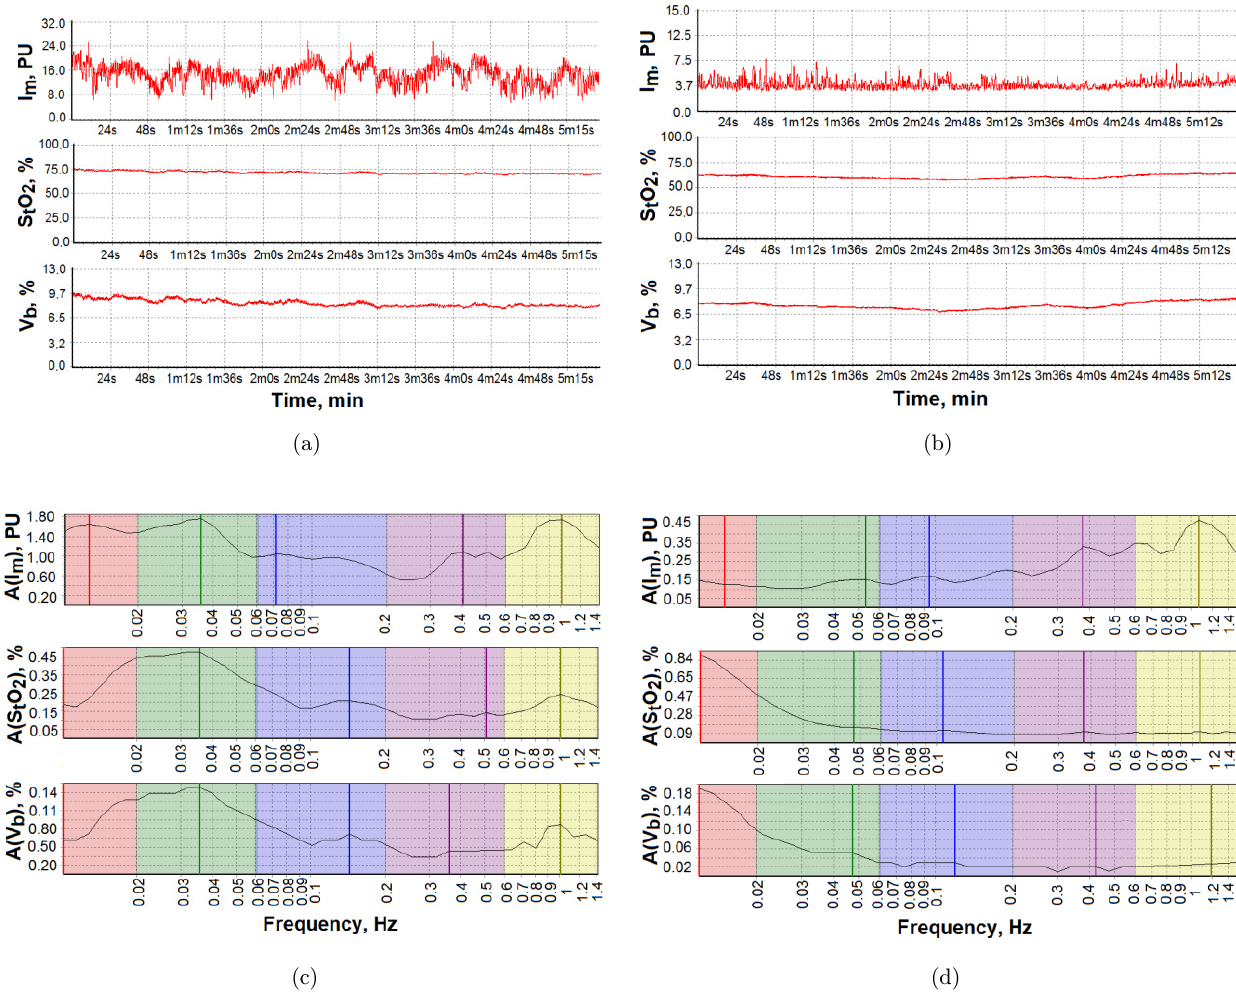
Fig. 2. Examples of registered LDF- and TRO-graphs and their amplitude-frequency spectrums before (a), (c) and after (b), (d) the cold pressor